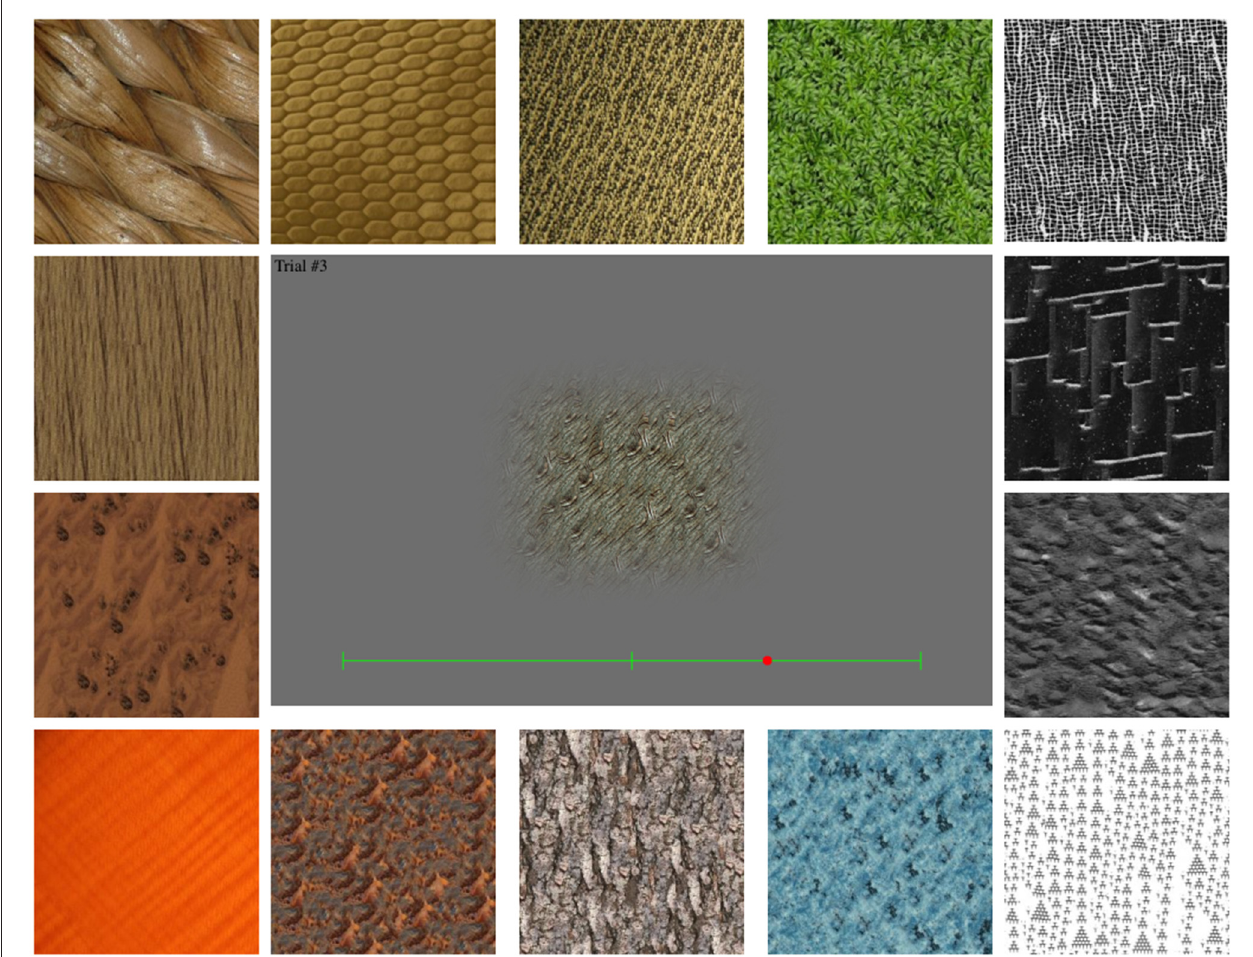
middle of the range. Four of each category are displayed in Figure 2